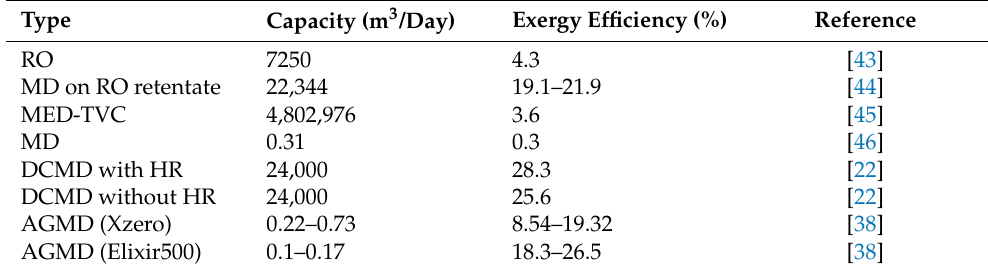
Table 1. Summary of exergy efficiency for different MD configurations from the